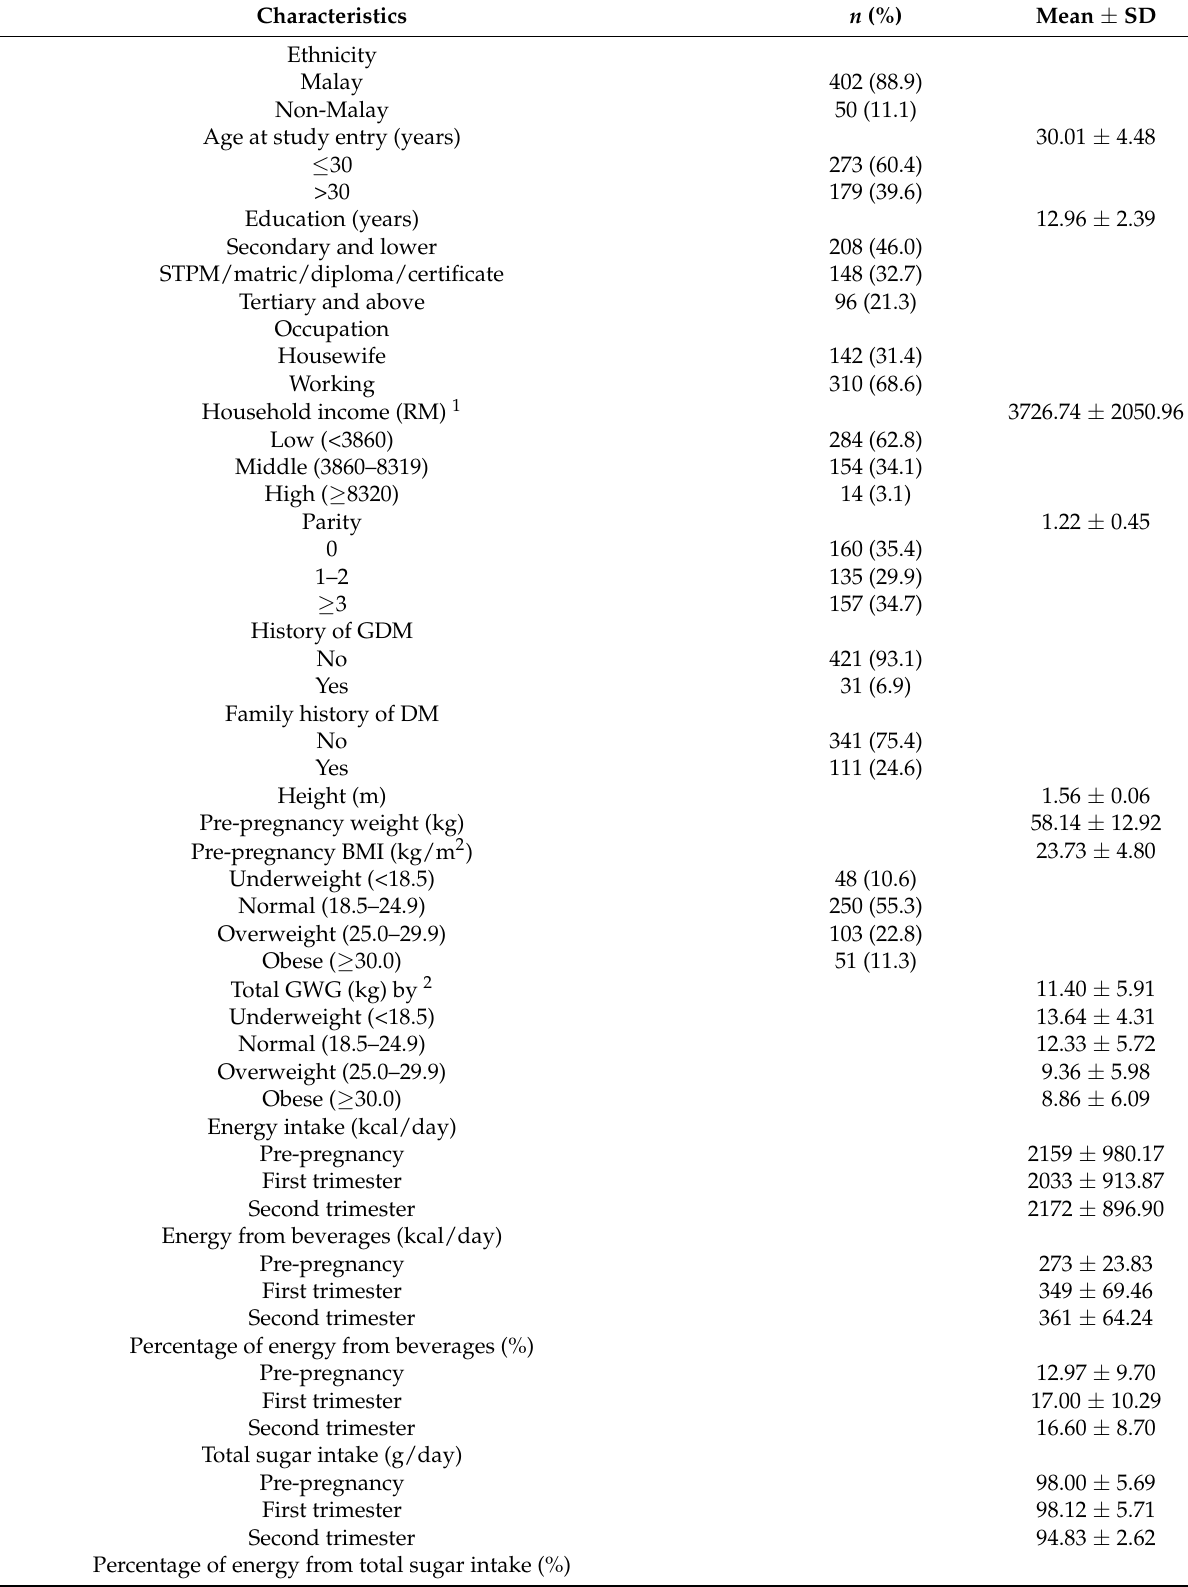
Table 1. Sociodemographic, obstetrical, anthropometric, diet, and blood glucose information of women ( n =